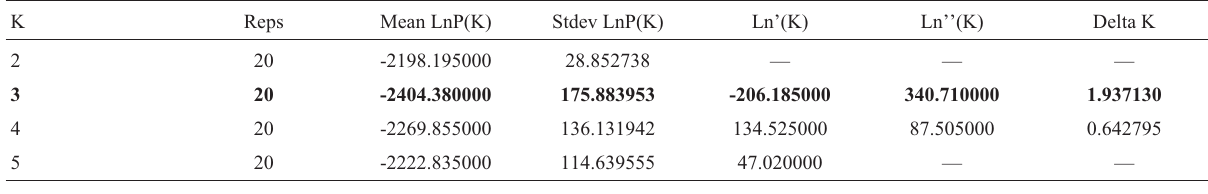
Table 4 - Most probable K (in bold letter) of the Structure analysis shown above. Performed with Structure Harvester